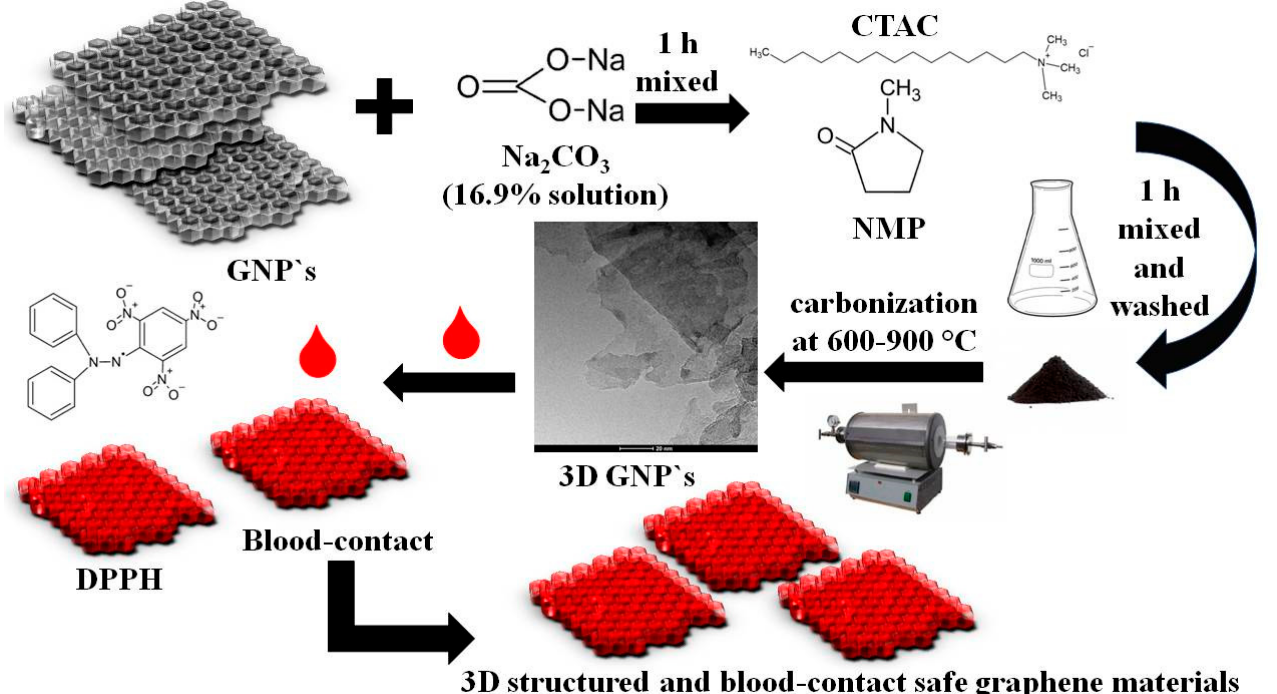
Figure 1. The proposed method of synthesis of blood-contact-safe 3D graphene materials.